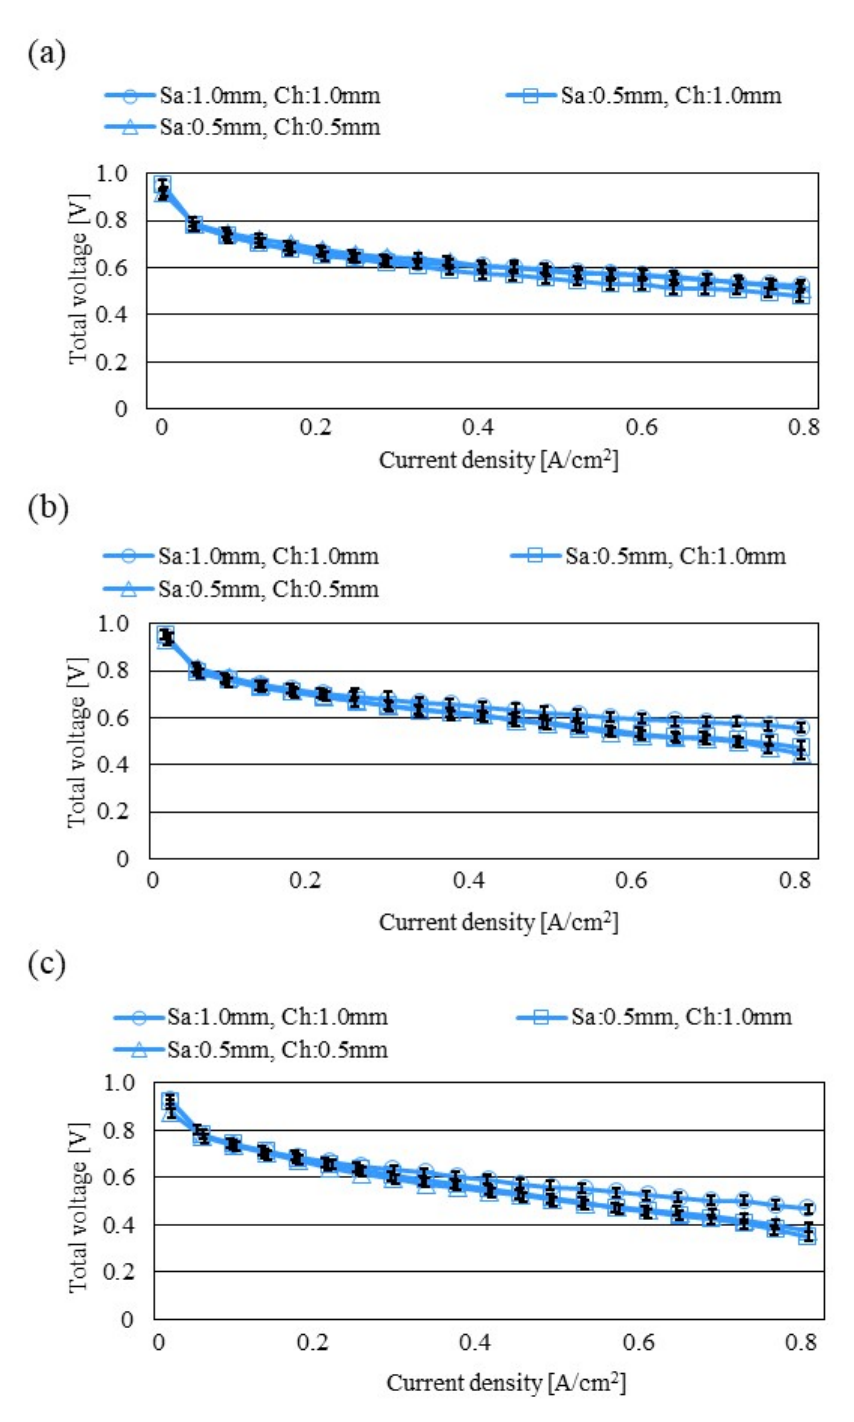
Figure 7. Comparison of polarization curves among different separator thicknesses with A80%RH&C80%RH: ( a ) T init = 353 K; ( b ) T init = 363 K; ( c ) T init = 373 K.